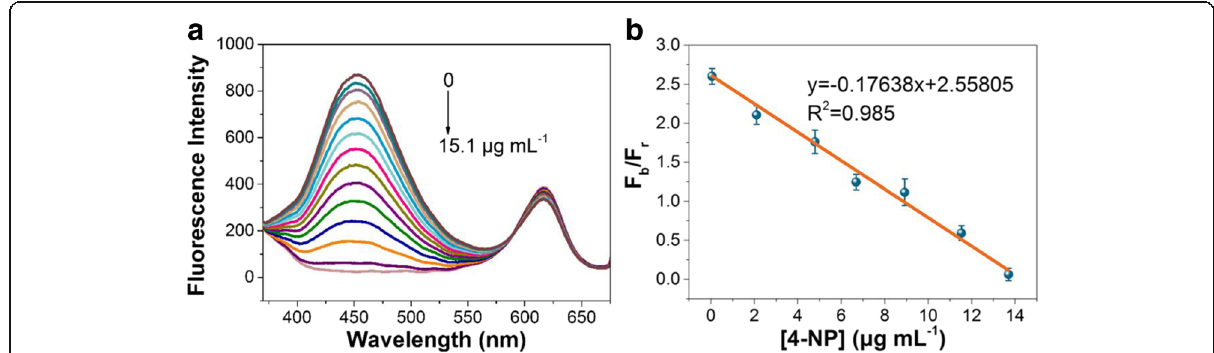
Fig. 4 The detection of 4-NP. a Fluorescence spectra of the CdSe@SiO 2 /CD/MIP nanohybrids obtained at increasing 4-NP concentrations under an excitation wavelength of 350 nm. b Effect of 4-NP concentration on the ratio of F r to F b for the MIP-coated CdSe@SiO 2 /CD nanohybrids. 4-NP concentrations of 0.051, 2.1, 4.8, 6.7, 8.9, 11.52, and 13.7 μ g/mL were employed. F b and F r represent the fluorescence intensities of the CdSe@SiO 2 / CD/MIP nanohybrids at 455 and 615 nm, respectively